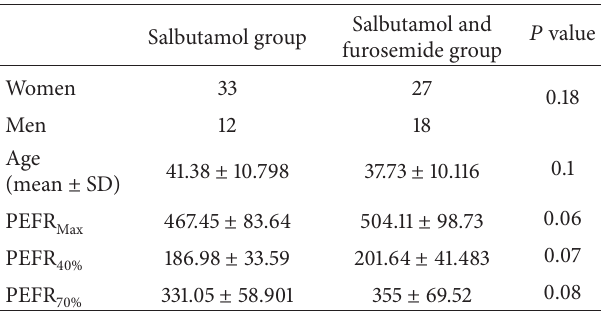
Table 1: Comparison of sex, mean age, mean of PEFR , and mean of PEFR PEFR 40%